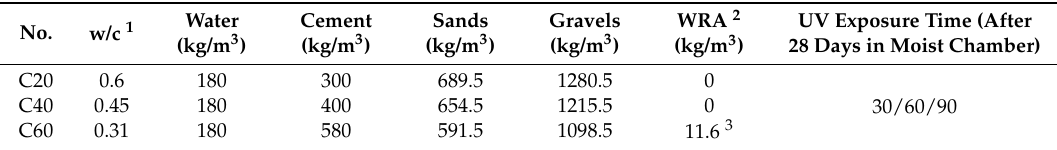
Table 3. Details of concrete mix.